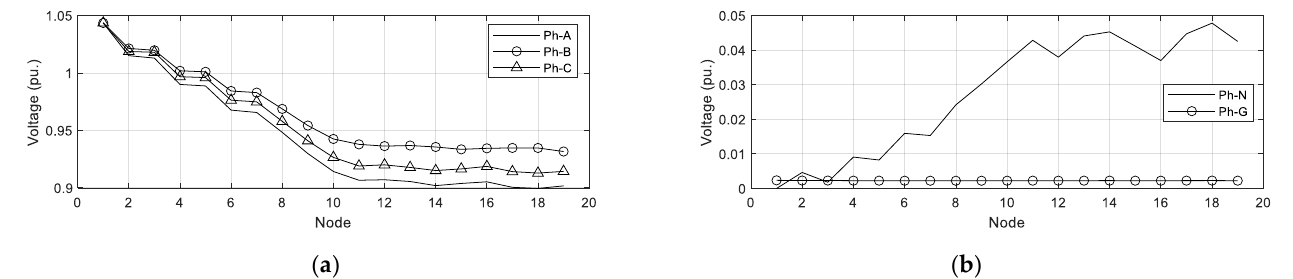
Figure 10. Phase voltage results of ( a ) Phase − A, − B, and − C and ( b ) Phase − N and − G.